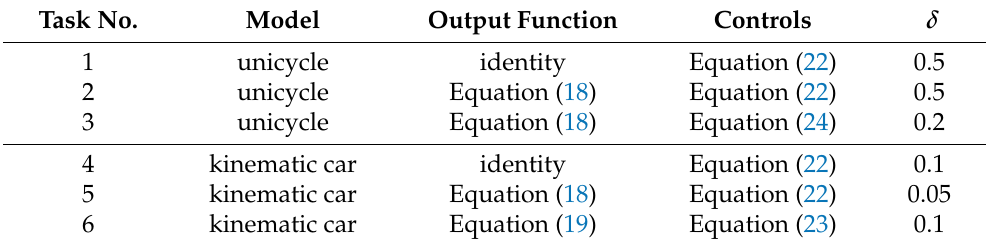
Some numeric data describing the quality of solutions were collected in Tables 2 and